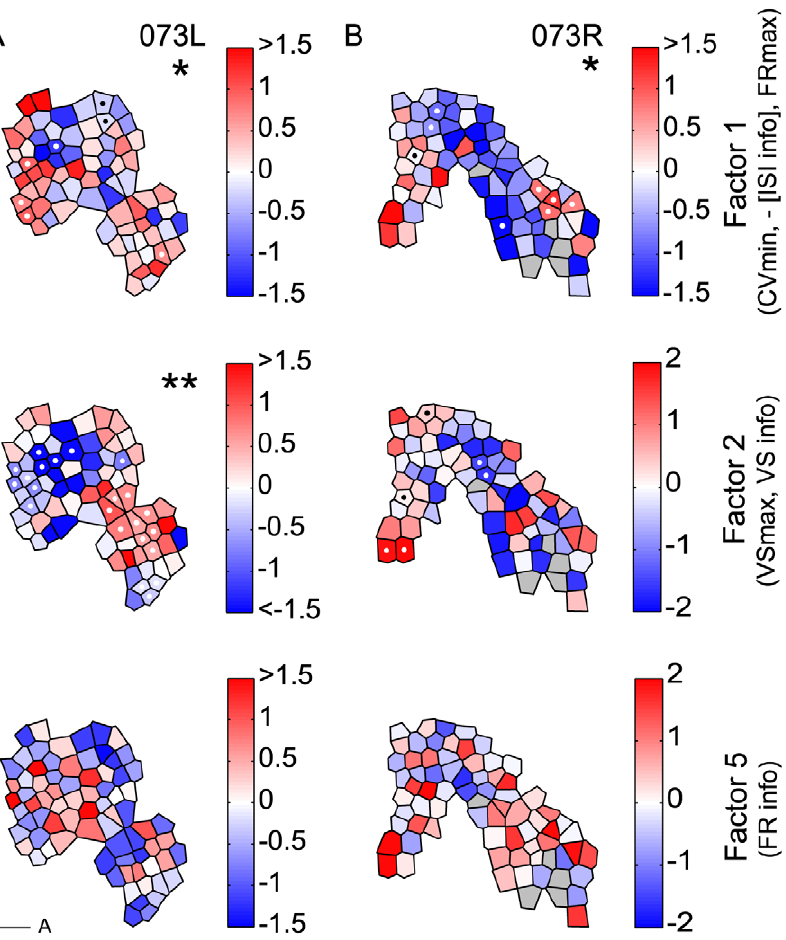
Figure 7. Spatial distributions of temporal response factors. (A) Spatial distribution of the magnitudes of three temporal factors based on a principal component analysis of CV min, FR max, VS max as well as the three corresponding information measures (hemisphere 073L). White and black dots indicate polygons with statistically similar values than their direct neighbors (compared to random re-distribution of all neighbors, see Materials and Methods). Significant local clustering: *: p , 0.05; **: p , 0.01. D: dorsal, A: anterior, scale bars: 1 mm. For the tonotopic gradient, see Figure S3. (B) Same as (A) for hemisphere 073R.